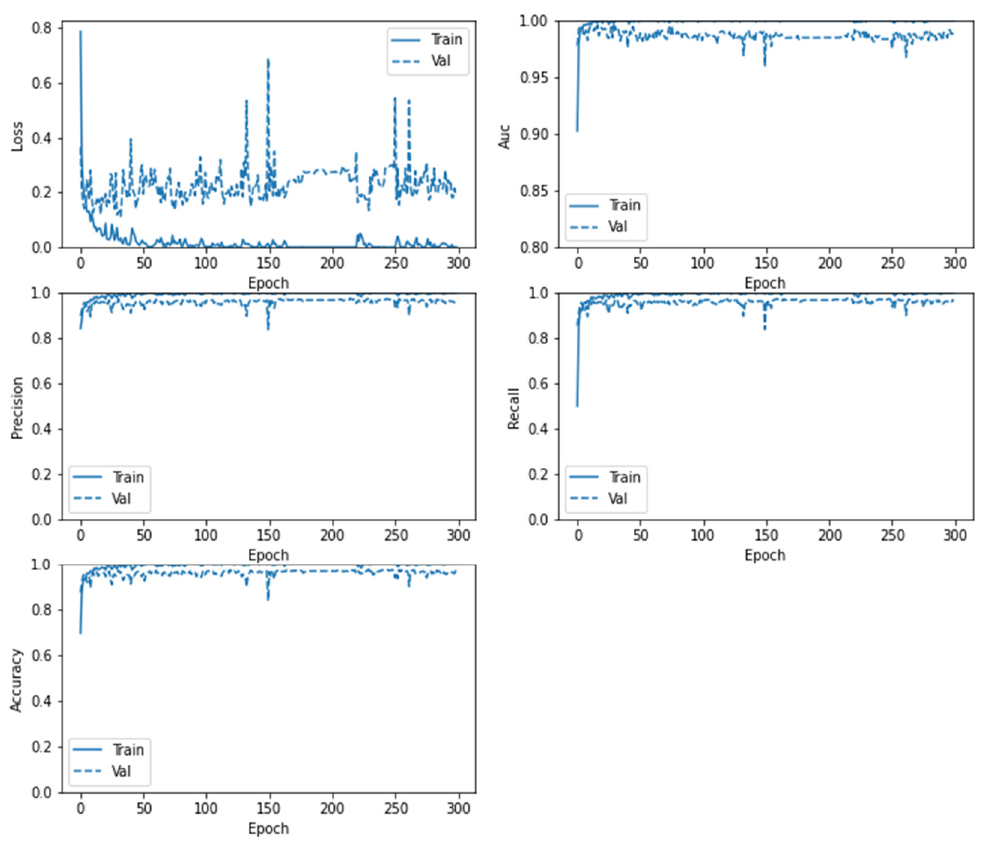
Figure 13. Loss, AUC, precision, recall, and accuracy between the training and validation phases with the number of epochs for the ResNet152V2 model using DCGAN image generated.